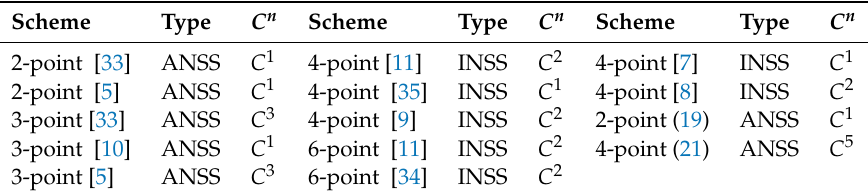
Table 1. Comparison of the even-point nonstationary subdivision schemes (NSSs) with existing subdivision schemes